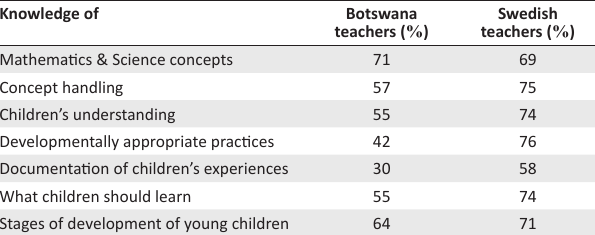
TABLE 1: The preschool teachers’ knowledge bases. Knowledge of Botswana